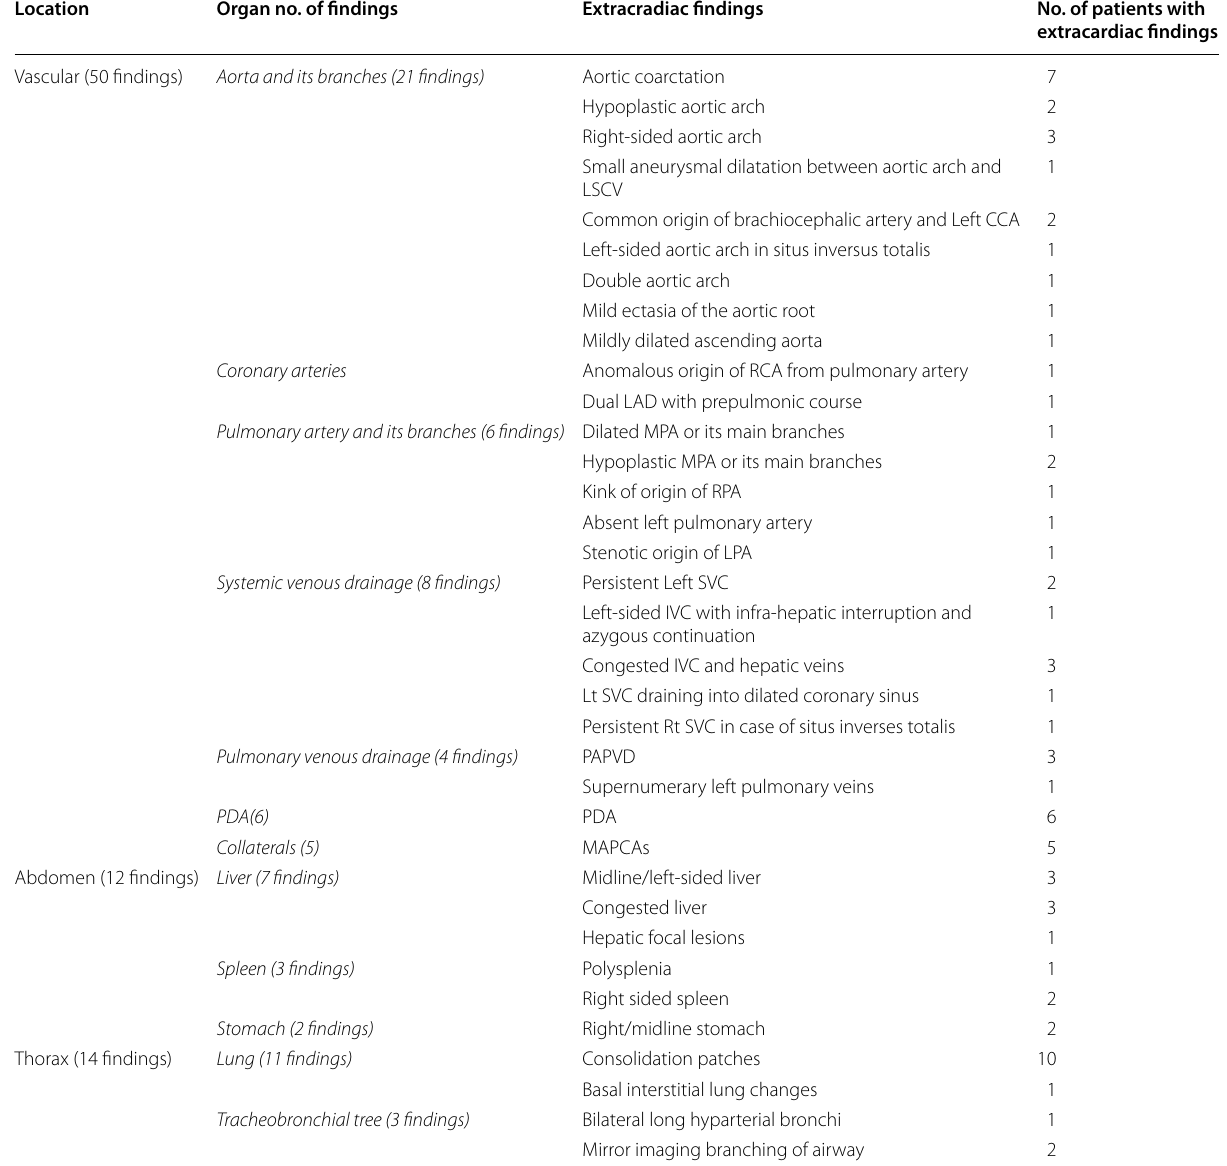
Twelve patients had more than one extracardiac finding